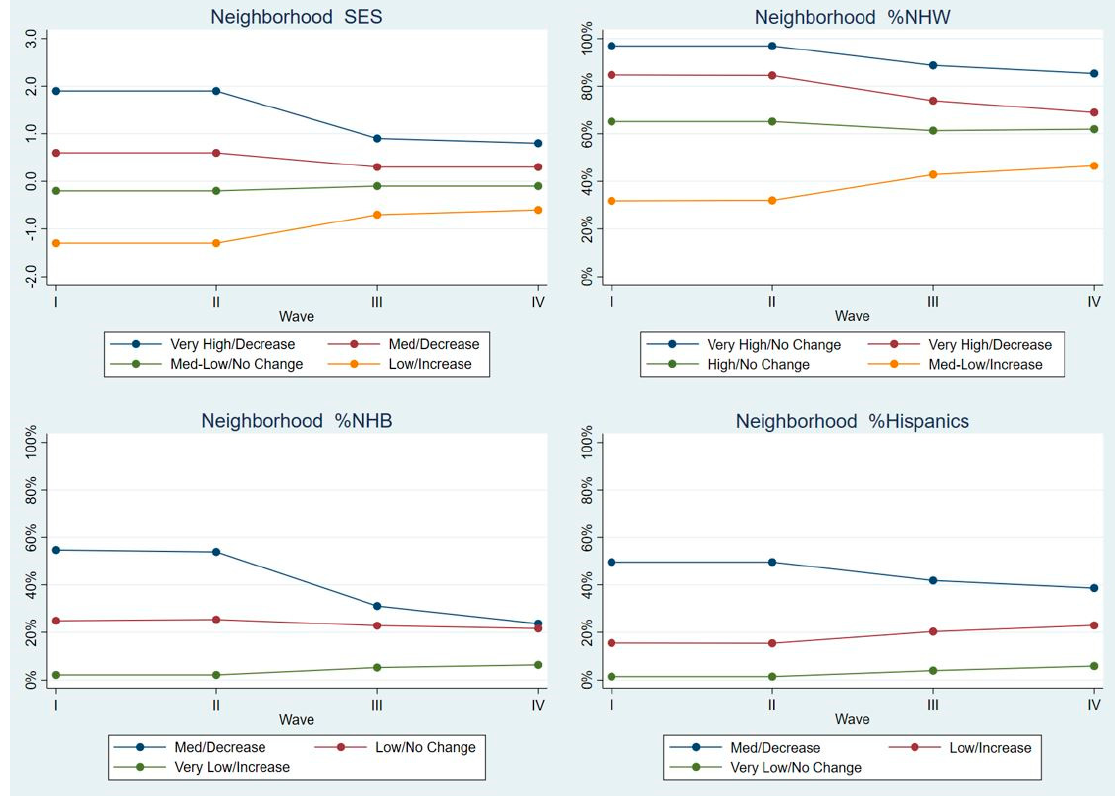
Figure 1. Latent class means for each neighborhood characteristic by Wave, Non-Hispanic Whites.